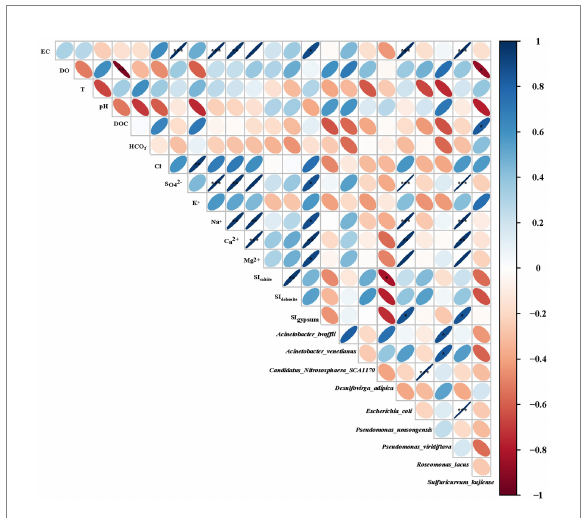
FIGURE 5 Correlation heatmap for groundwater environmental parameters and microbe species (In brief, orange and red colors indicate negative correlations, blue colors indicate positive correlations and the strength of color indicates the magnitude of correlation coefficient, as shown on the correlation spectrum, insert right; * p < 0.05, ** p < 0.01, *** p < 0.001).